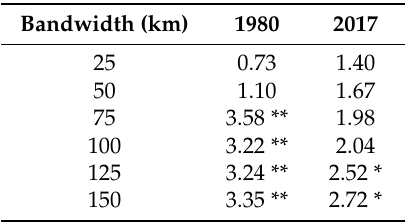
Table 3. Global Moran’s spatial autocorrelation index ( z -score) of the gender gap (years) in mean age at marriage by year and bandwidth (km); significant correlations at * p < 0.05 and ** p < 0.01. Bandwidth